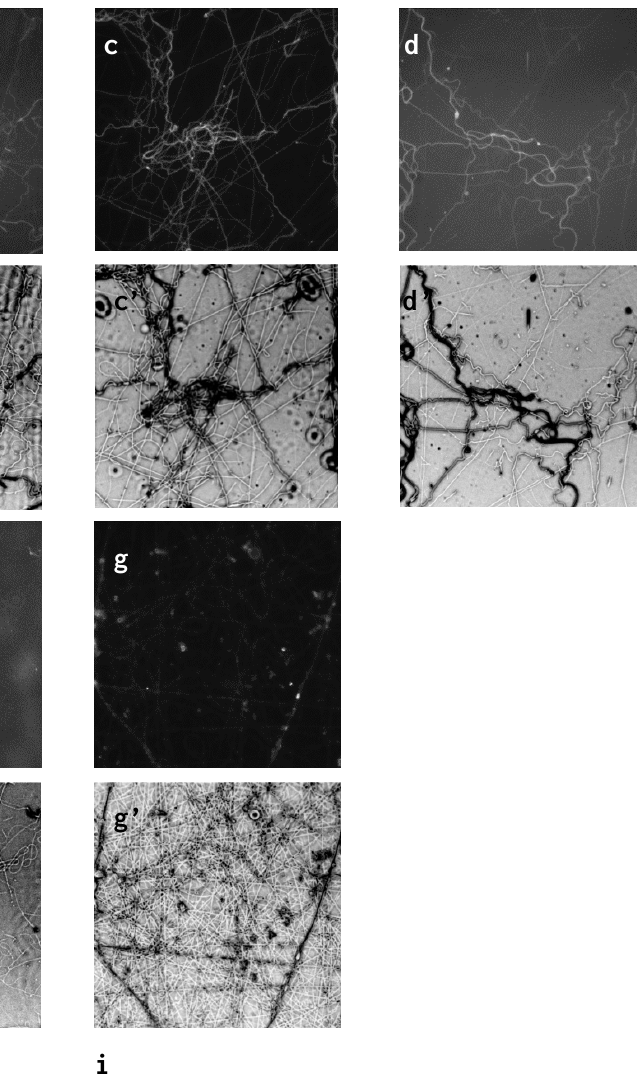
Figure 5. Protein adsorption onto fibers or glass. Proteins became deposited during overnight incubation at 37 °C. Bright-field images have been inverted and equalized to increase contrast; there was no processing of the fluorescence